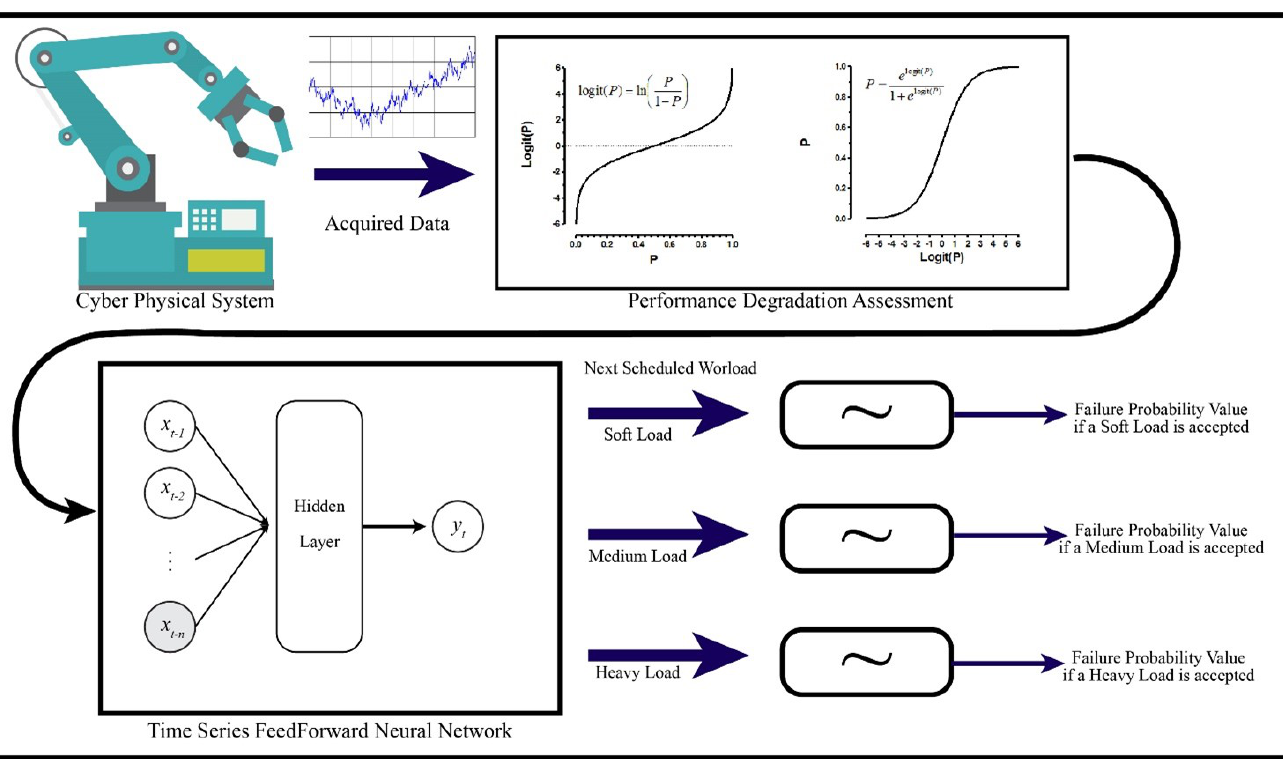
Figure 2. Self-detected condition-based maintenance